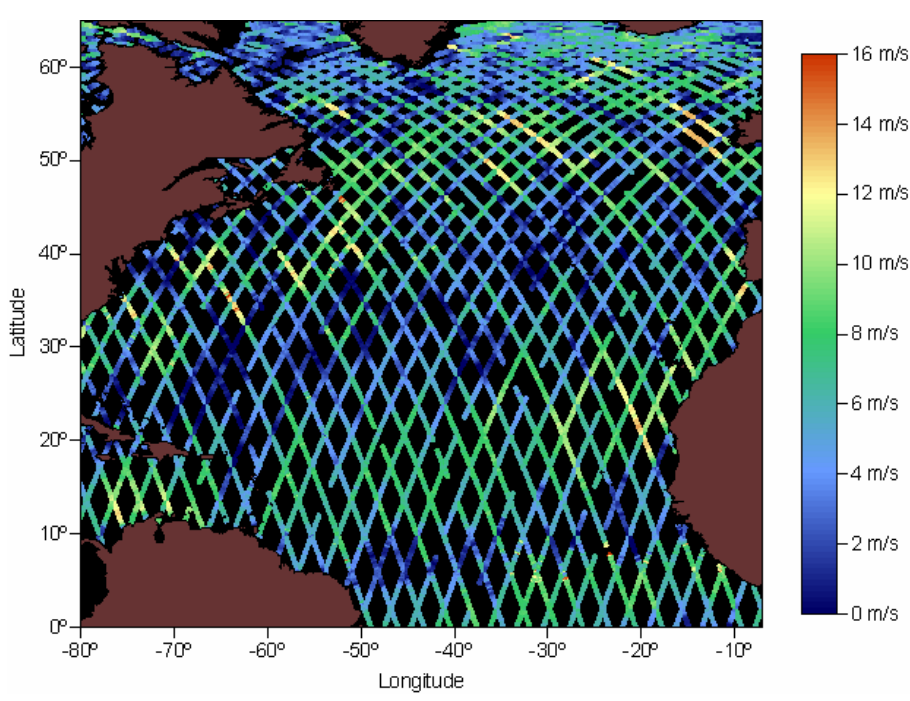
Figure 16b. Wind speed for cycle 364 (August